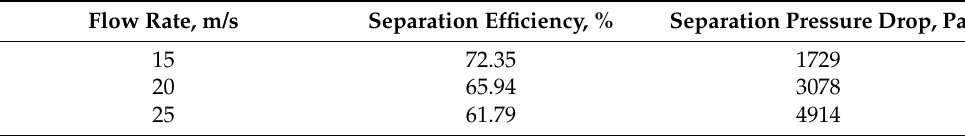
Table 4. Effect of the flow rate on the gas–liquid separation performance.